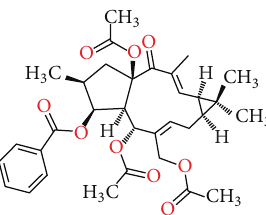
Figure 1: The structure of L713283 ligand.